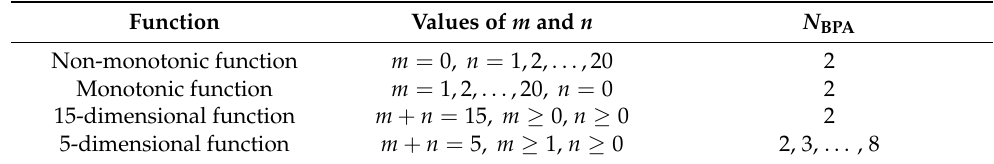
Table 1. Information on the four functions.